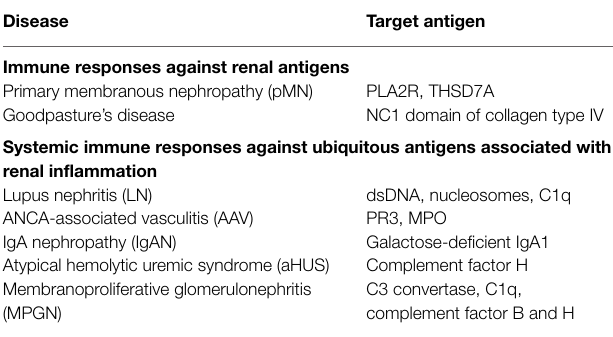
TABLE 1 | Renal autoimmune diseases and associated autoantigens .